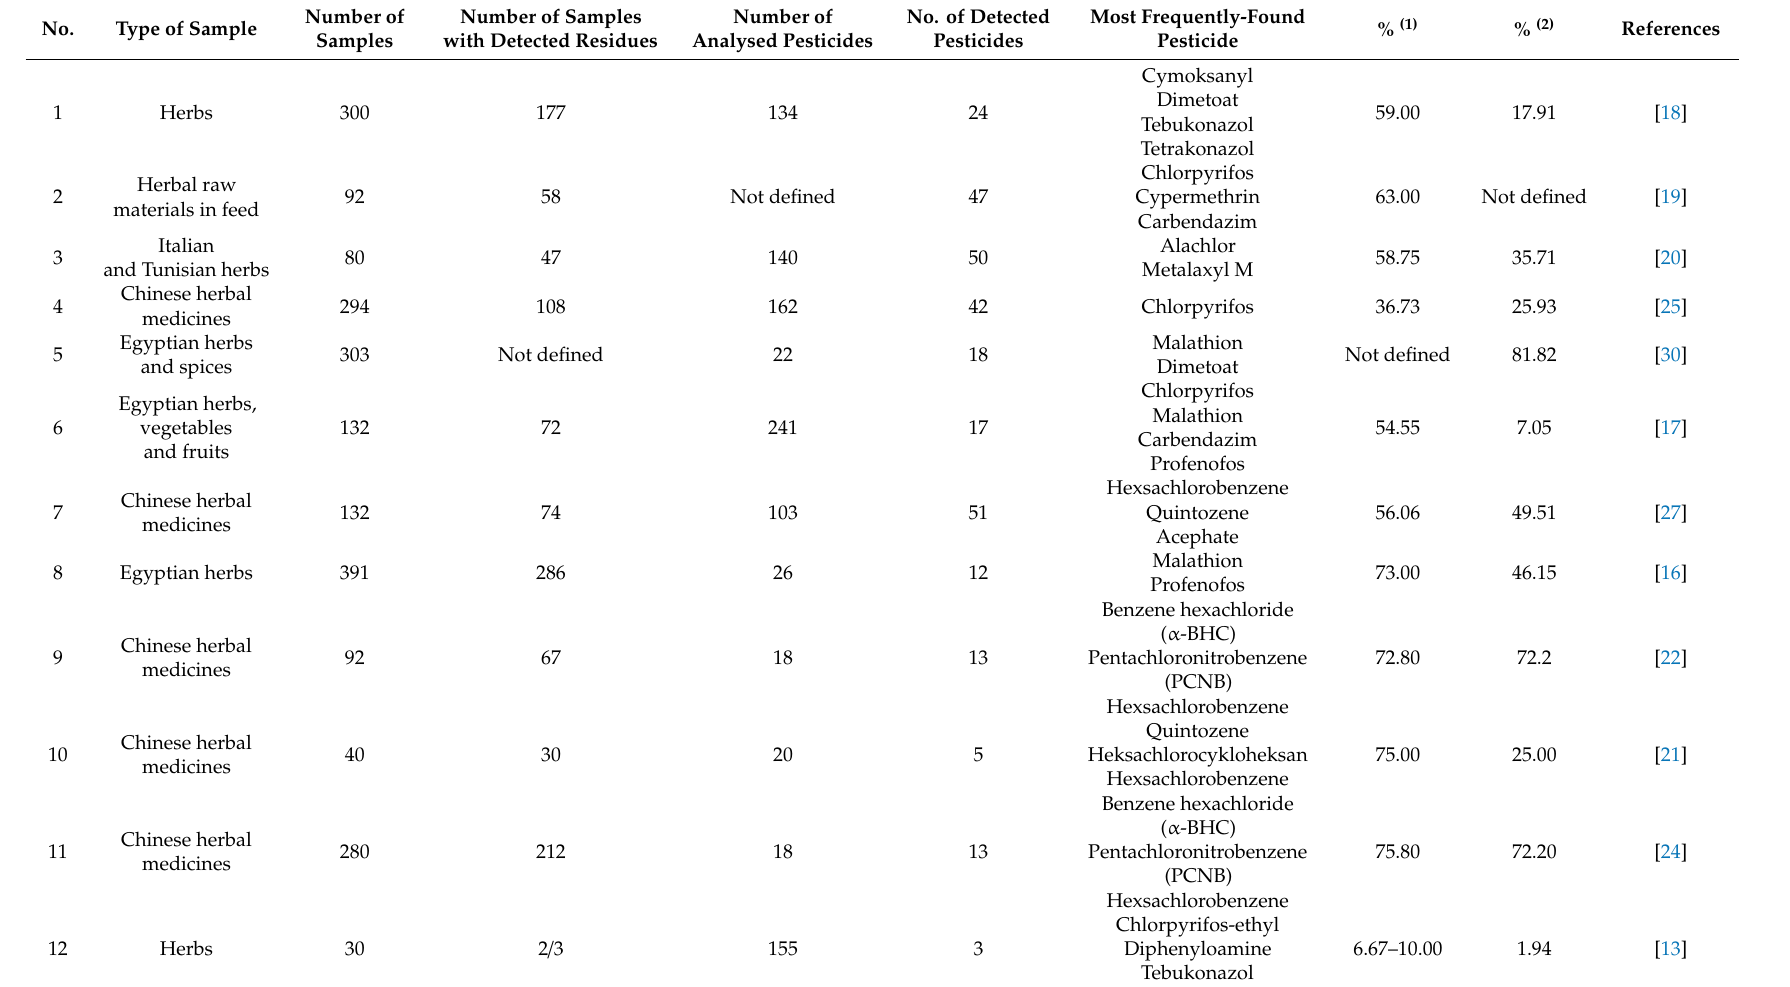
Table 3. Summary of the most-frequently-detected pesticides in di ff erent herbs samples reported in the